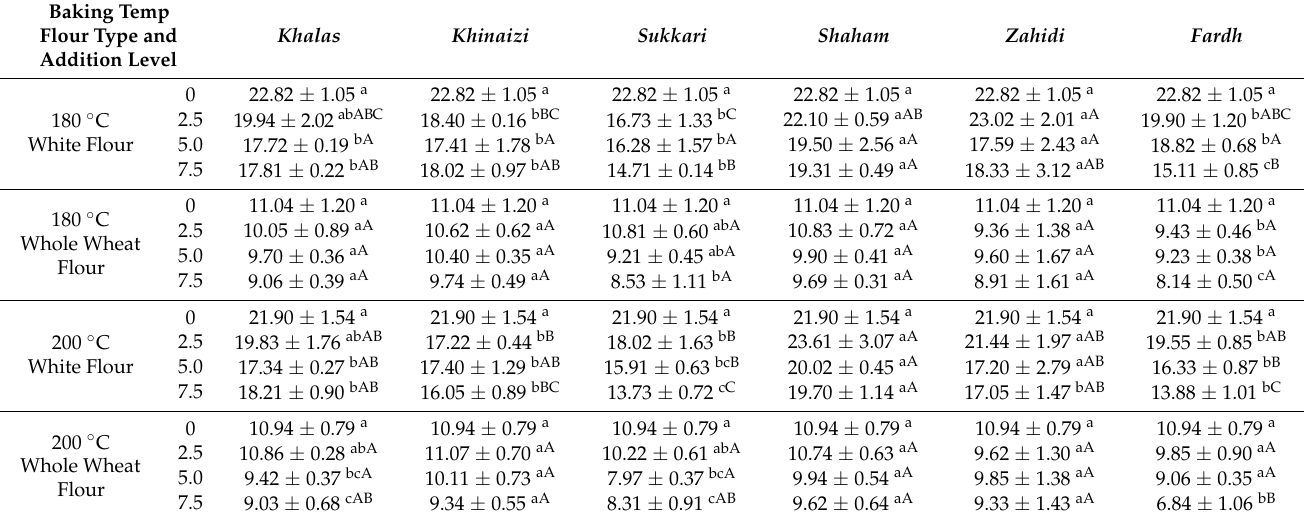
Table 6. Hardness assessments of cookies